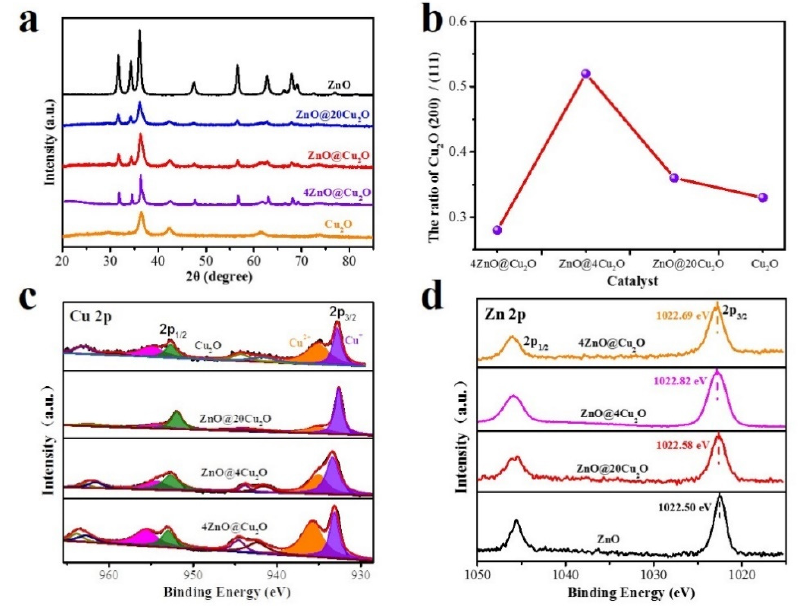
Figure 3. ( a ) XRD patterns of xZnO@yCu 2 O catalyst. ( b ) The ratio of Cu 2 O (200) facet/(111) facet on different catalysts. ( c ) Cu 2p XPS diagrams and ( d ) Zn 2p XPS diagrams of different shell thickness catalysts.